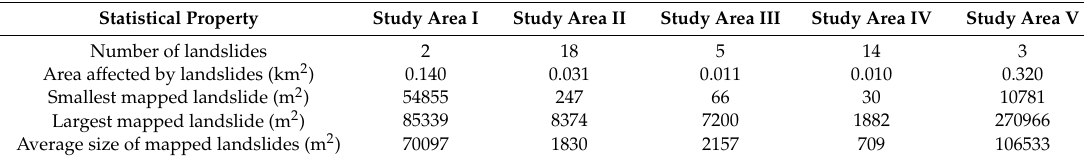
Table 6. Statistics of the manual mapping results for each of the five study